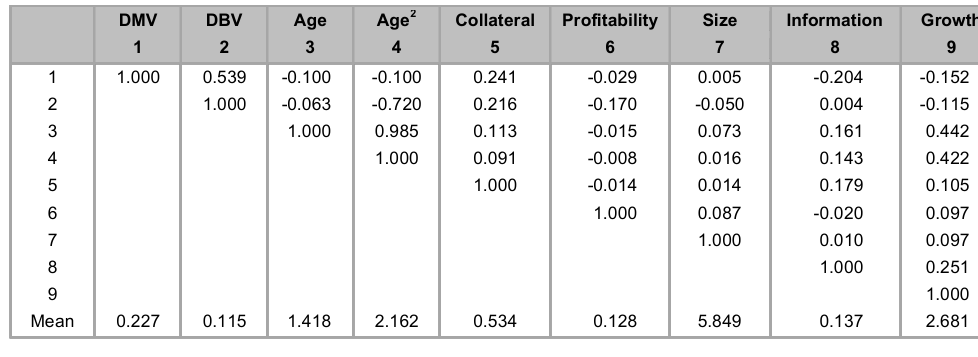
Summary statistics and pairwise correlation matrix